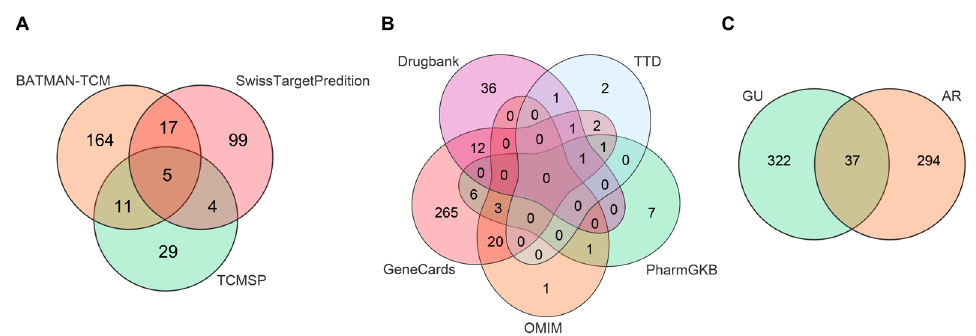
Figure 2. Target screening involved in AR for the treatment of GU. ( A ) Venn diagram of potential targets of AR. ( B ) Venn diagram of disease targets. ( C ) Venn diagram of potential targets of AR for the treatment of GU.